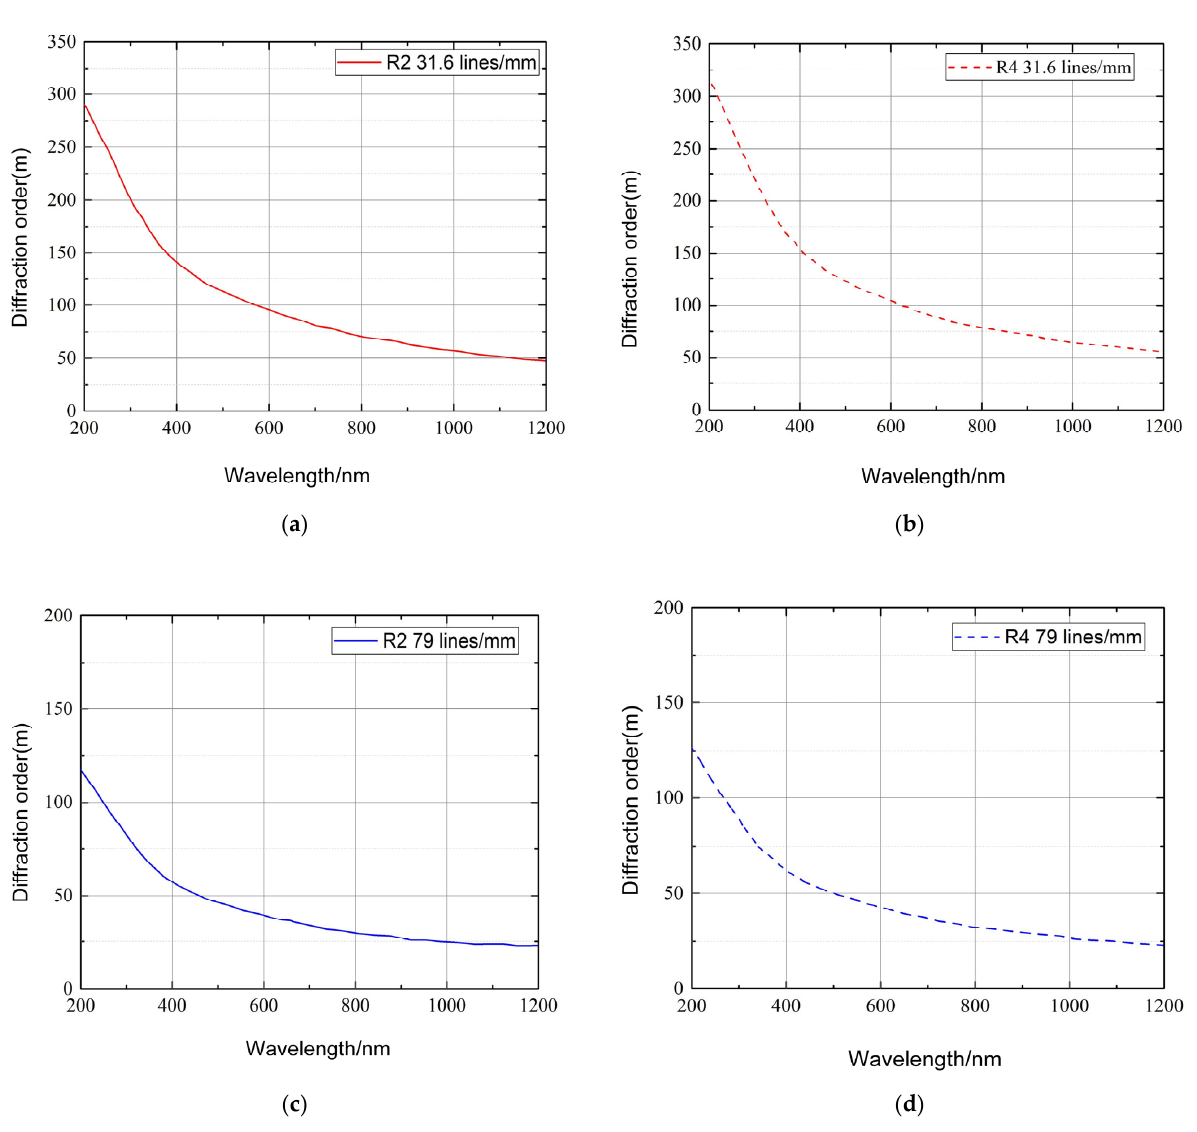
Figure 12. Relationships between wavelength and diffraction order for typical grating line densities and blaze angles: ( a ) 31.6 lines/mm, blaze angle 63.4°; ( b ) 31.6 lines/mm, blaze angle 75°; ( c ) 79 lines/mm, blaze angle 63.4; ( d ) 79 lines/mm, blaze angle 75°.